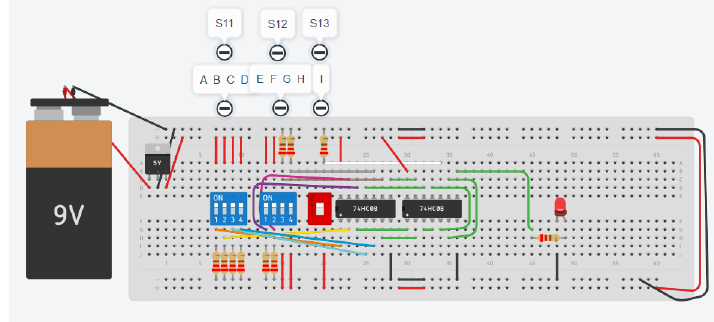
Figure 6. Draw circuit